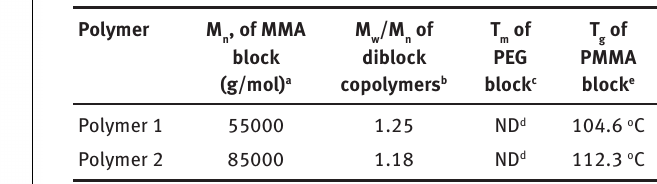
Table 1: Characterization results of acid cleavable PEG- b -PMMA diblock